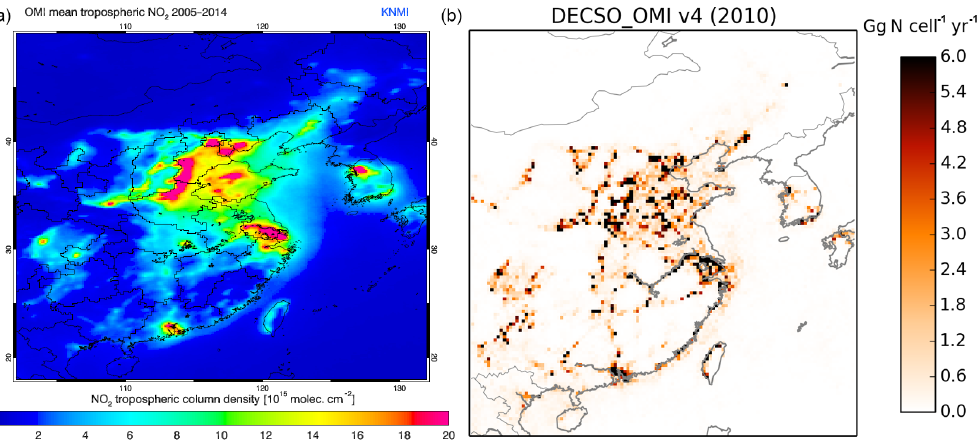
Figure 3. (a) The averaged tropospheric NO 2 concentrations over China measured by OMI in the period 2005–2014. (b) The NO x emissions in the year 2010 derived from OMI satellite observations. Table 3. Main power plants in Ningxia province (>600MW). Data collected from www.sourcewatch.org. Power plant Capacity (MW) In operation since